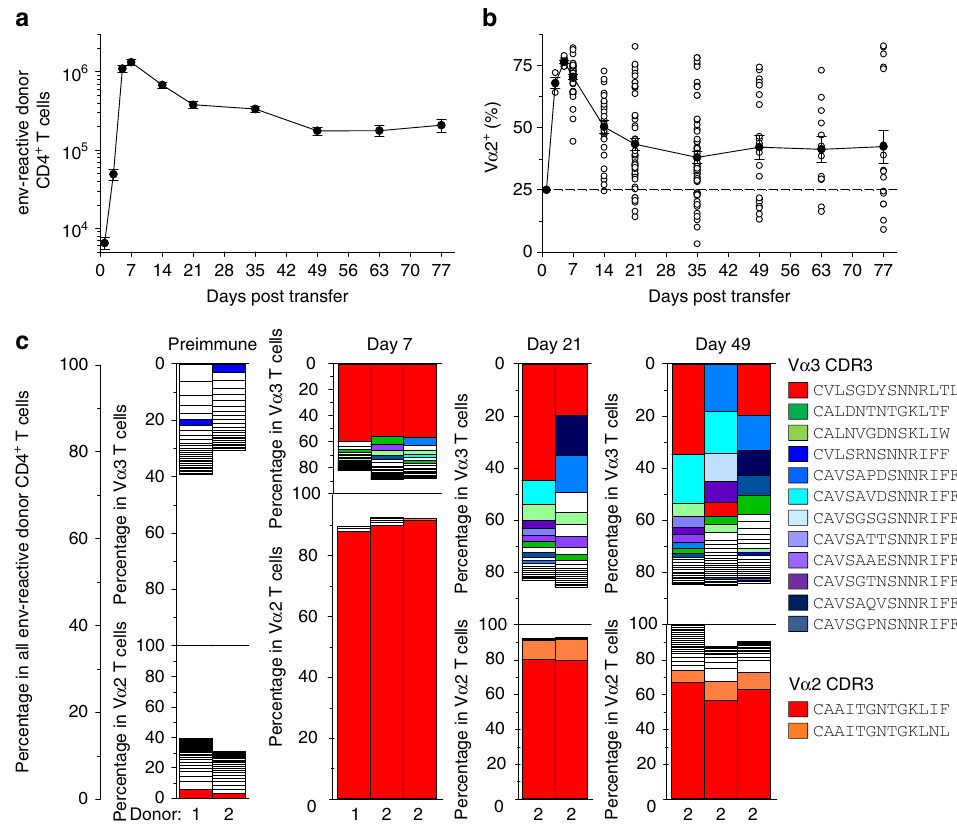
Figure 1 | Clonotypic diversity of virus-specific CD4 þ Tcells increases over the course of FV infection. ( a ) Absolute numbers and ( b ) V a composition of env-reactive donor EF4.1 CD4 þ T cells in the spleens of recipient mice after adoptive T-cell transfer and FV infection ( n ¼ 9–61 mice per time point; P o 0.001 between V a 2 frequency on day 7 and any later time point, Mann–Whitney rank sum test). ( c ) Frequency of various V a 2 and V a 3 clonotypes in total EF4.1 CD4 þ Tcells from two uninfected donor mice (preimmune; donors 1 and 2) or in env-reactive EF4.1 CD4 þ Tcells from the spleens of recipient mice after adoptive T-cell transfer from the indicated donor and FV infection. Each bar graph represents an individual mouse. Clonotypes with frequencies o 0.5% are not plotted for simplicity. Identical clonotypes within V a 2 and V a 3 subsets are marked with the same color, with red color indicating the dominant V a 2 and V a 3 clonotypes. The scale of the V a 2 and V a 3 plots are adjusted to the relative ratio of the two subsets at a given time